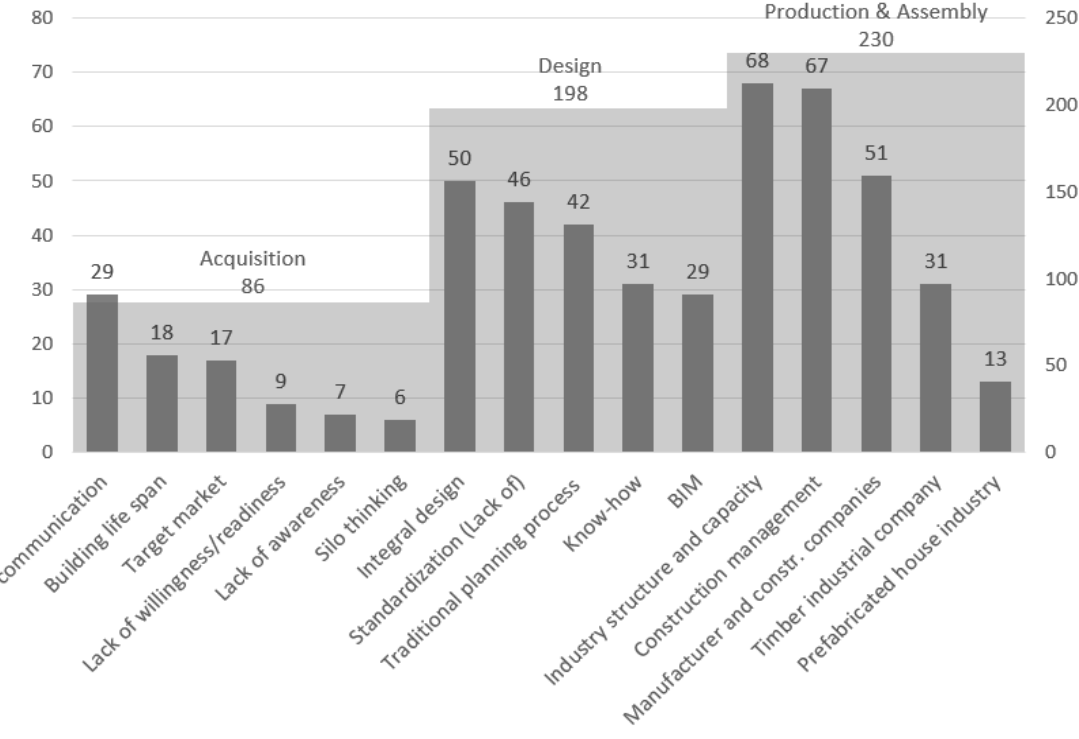
Table 3. Summary of results according to the frequency of nominations. Category